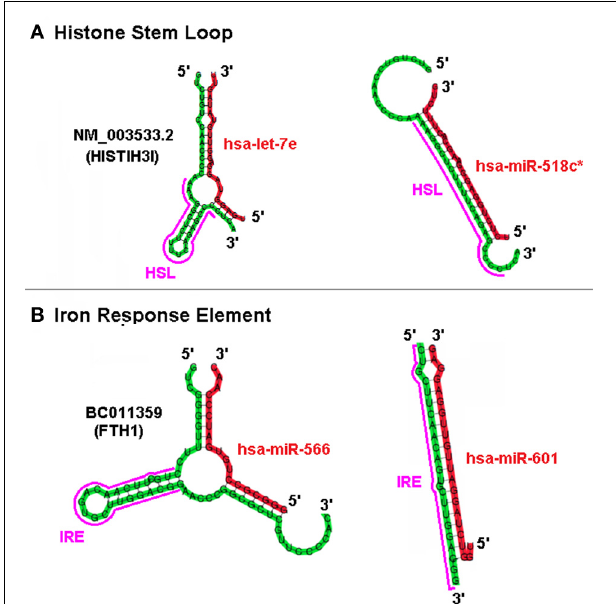
FIGURE 6 | Positive and Negative sxRNA Interactions on the HSL or IRE Motif. The UTR portion of two mRNA is depicted folded using co-Fold. Shown are, (A) NM_003533 (HIST1H3I) histone message and (B) BC011359 ferritin, heavy polypeptide 1. Each mRNA has a miRNA that either induces/strengthens the target stem loop RBP binding-site motif (HSL or IRE) or ablates